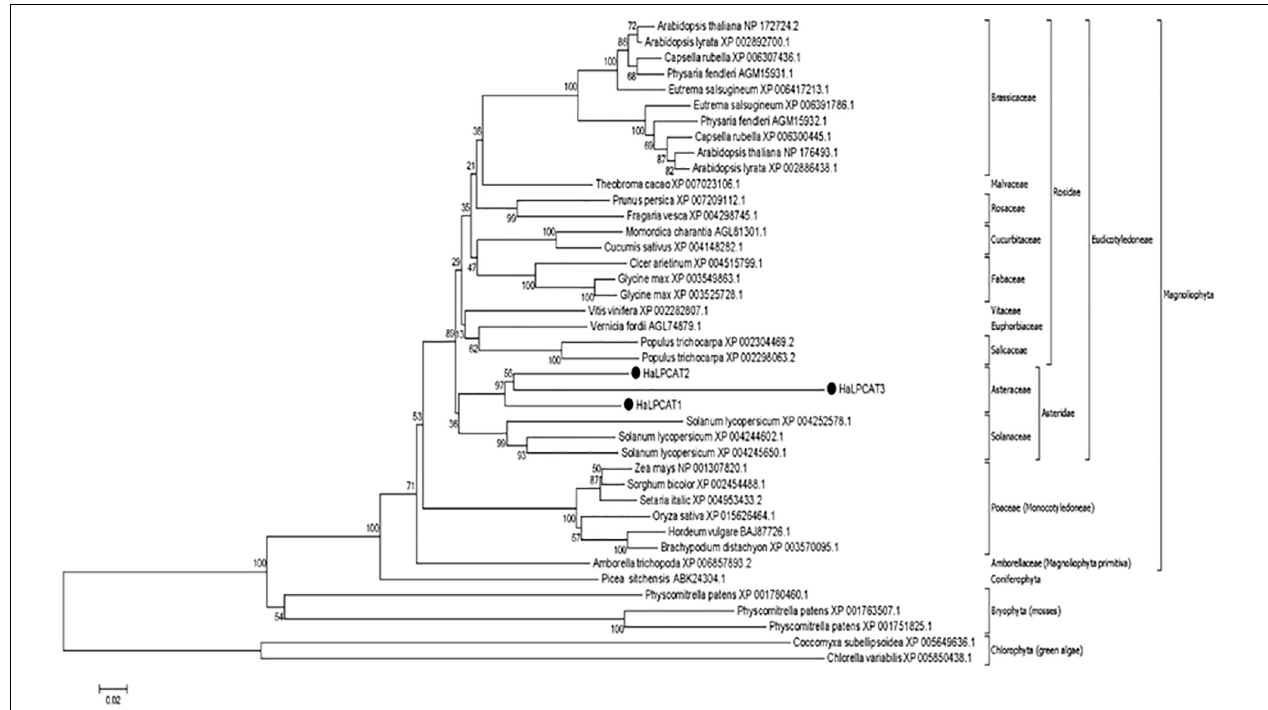
FIGURE 1 | Phylogenetic tree of different plant LPCAT proteins, including sunflower HaLPCAT1, 2, and 3. The tree was rooted with proteins from green algae (Chlorophyte). The groups and species included dicots, monocots, and bryophytes. The black dots indicate LPCATs from sunflower.